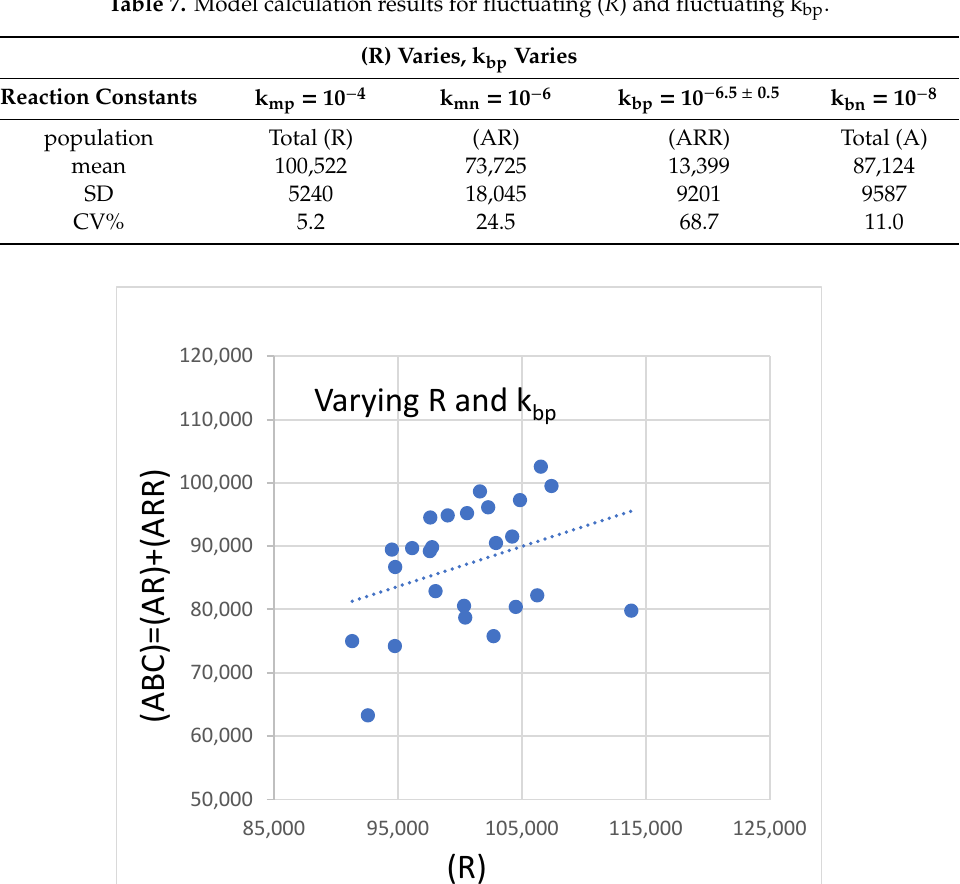
Table 7. Model calculation results for fluctuating ( R ) and fluctuating k bp .